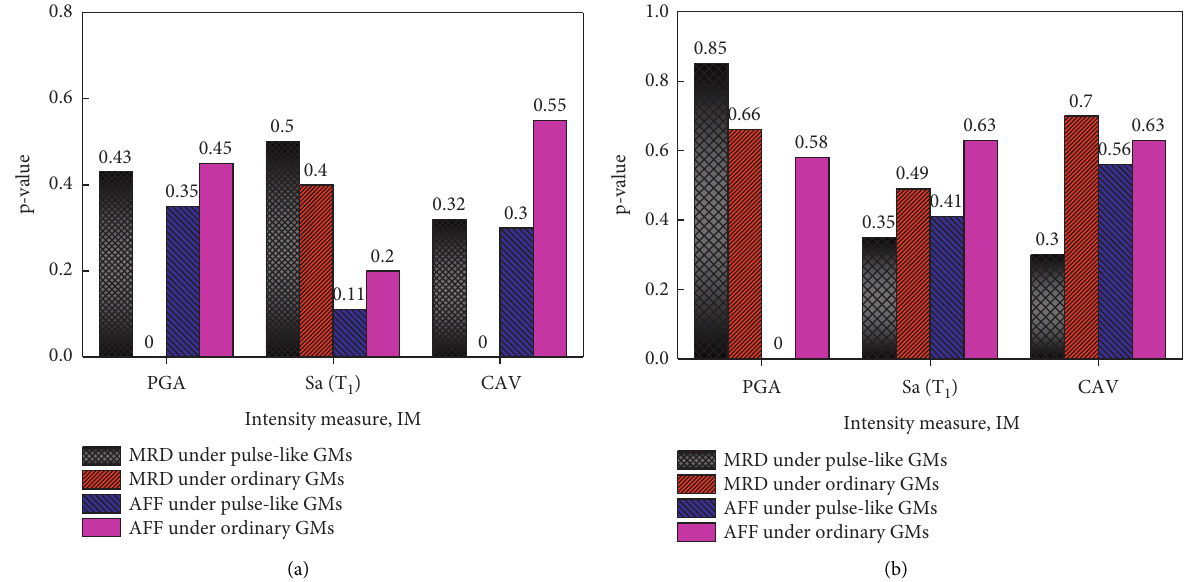
Figure 8: Median p values obtained from investigating the sufficiency of typical IMi with respect to (a) magnitude and (b) source-to-site